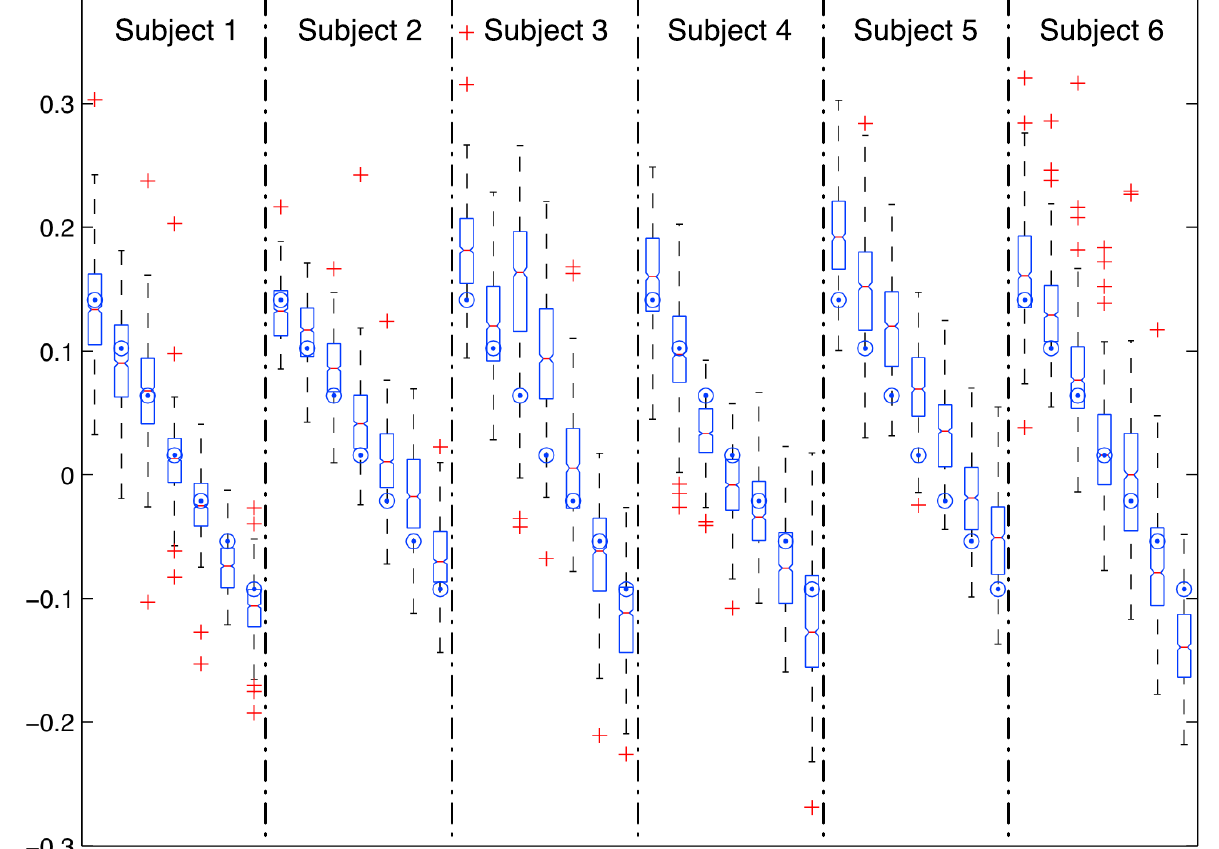
Figure 2. Raw estimations of the slope of the walking surface for the six subjects at the seven treadmill inclinations (0.14, 0.1, 0.06, 0.02, −0.02, −0.05, −0.09, from left to right for each subject). Big dots show the actual inclination of the treadmill for each experiment.